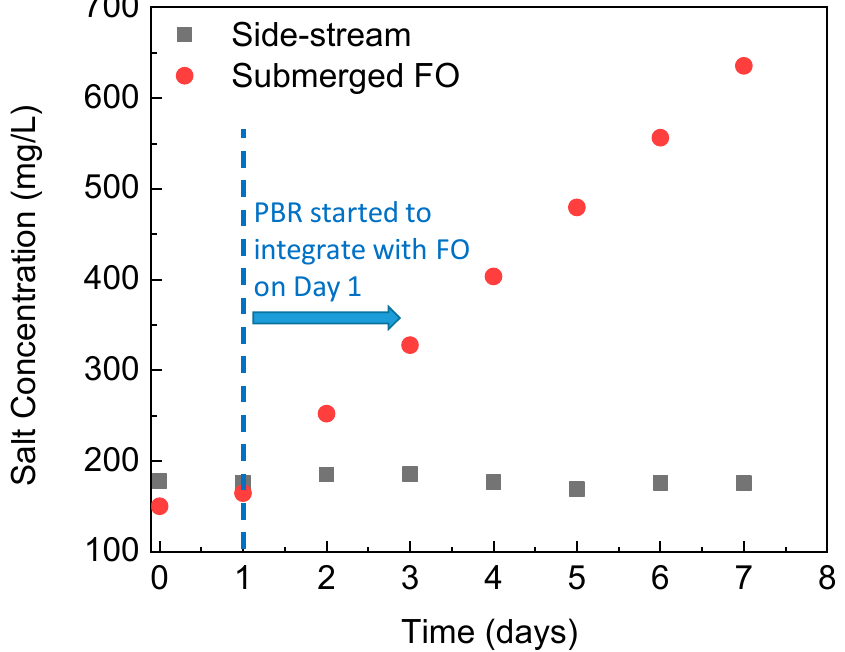
Figure 2. Changes in salinity in the PBR integrated with different FO configurations during a semi-continuous operation.